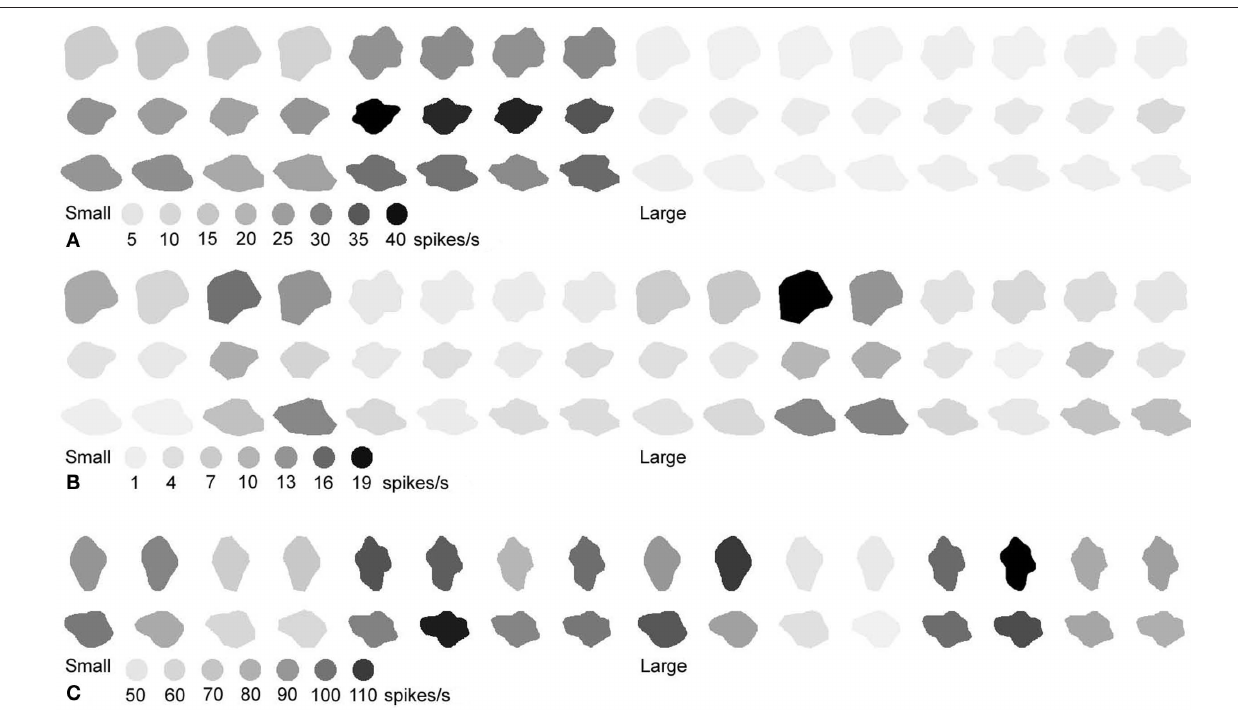
Figure 8 | responses of three neurons (A–C) to shapes from the set of Figure 2. The calibration bars underneath each of the sets indicate the response (in spikes/s.) corresponding to the different shades. The responses to the shapes on the left depict the responses to the small size versions of the